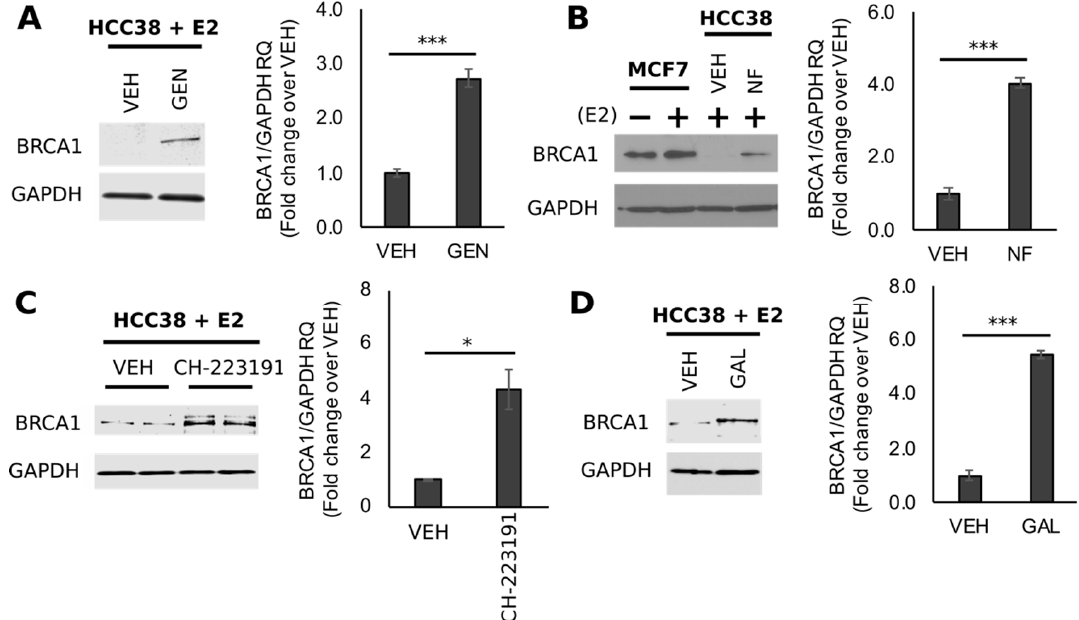
Figure 3. Genistein rescues BRCA1 protein levels in TNBC cells with CpG hypermethylated BRCA1 . Bands are immunocomplexes of BRCA1 and internal standard GAPDH in HCC38 cells treated with representative blots from ≥ 3 individual experiments. For densitometry histograms, bars represent mean RQ ± SEM from ≥ 3 biological replicates from individual experiments. Asterisks indicate significant differences (*, p<0.05; ***, p<0.001).